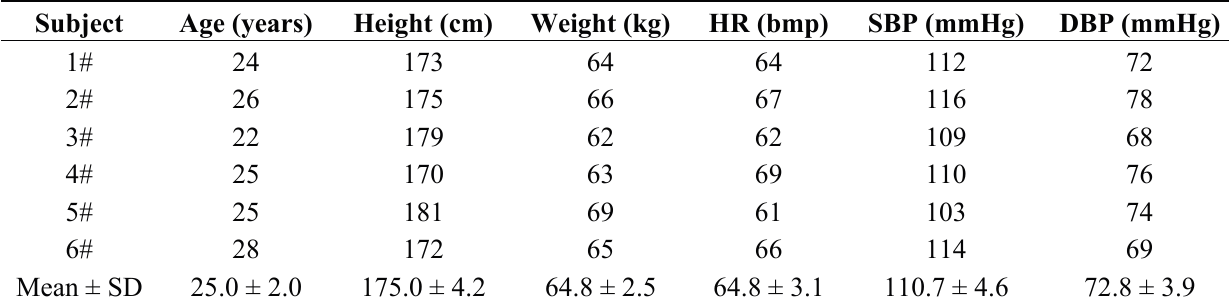
Table 1. Characteristics of